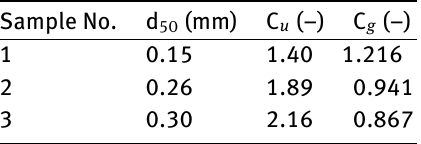
Table 4: Uniformity and gradation coeflcients of tested soils Sample